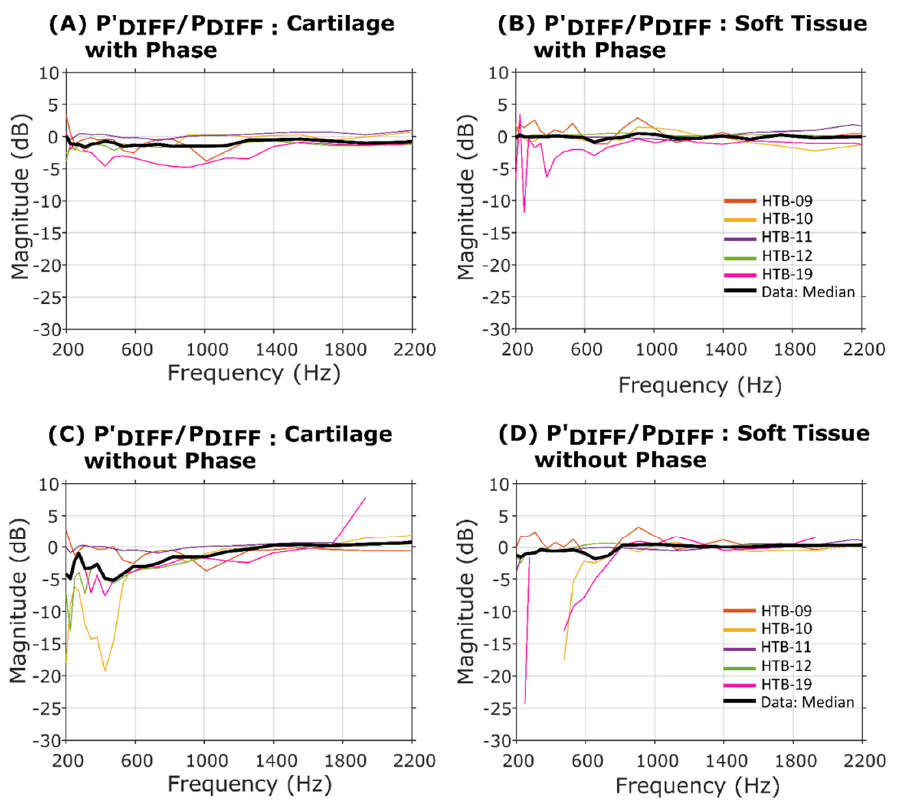
Figure 11. Ratio between the pressure difference across the cochlea partition normalized to the ear canal pressure ( P SV − P ST ) after and prior RWM reinforcement with cartilage ( A , C ) and soft tissue ( B , D ). In ( A , B ), P DIFF was calculated in the complex space considering the phase shift between P SV and P ST . In ( C , D ), zero phase shift was assumed for the P DIFF calculation. Invalid data (discontinuous curves) arise due to the uncertainties in the sensor measurements, and other interfering effects were